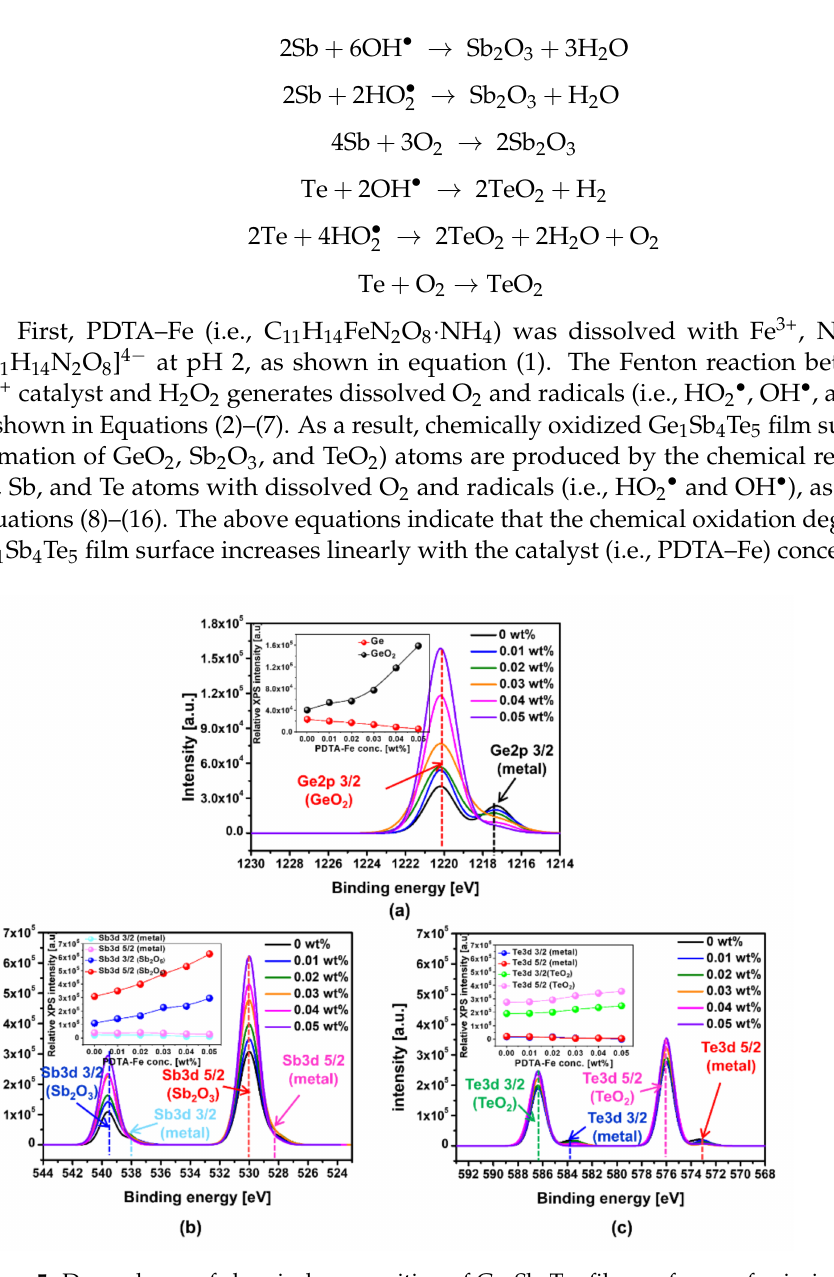
Figure 5. Dependency of chemical composition of Ge 1 Sb 4 Te 5 film surface on ferric–ionic catalyst (i.e., PDTA–Fe) concentration after dipping of Ge 1 Sb 4 Te 5 film surface into slurries. ( a ) Ge 2p spectra, ( b ) Sb 3d spectra, and ( c ) Te 3d